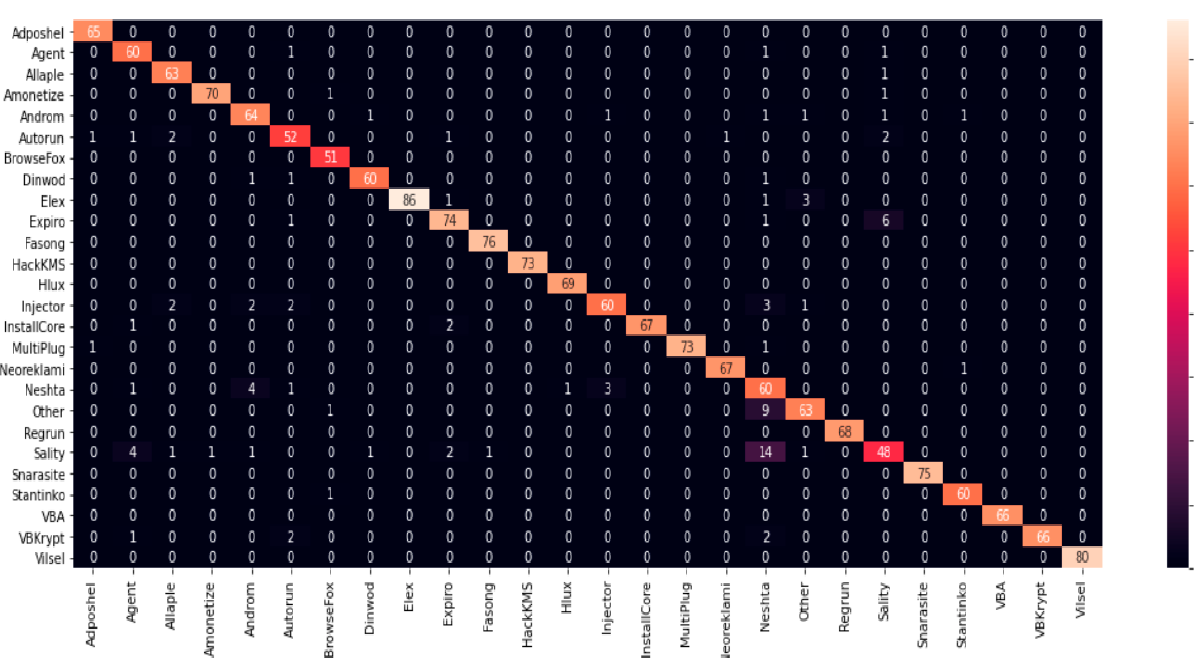
Figure 14. Training and testing loss of CNN.